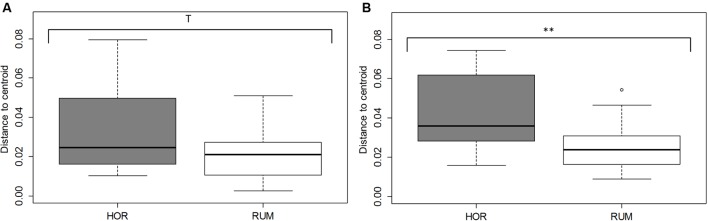
Dispersion of fermentation parameter data [molar concentrations of Ammonia, Acetate, Propionate, N-butyrate, branched-chained VFA and Lactate, log concentrations of LAB, AAB and yeast, pH and coefficients “a+b” (potential of fermentation) and “c” (speed of fermentation)], measured as distance form their corresponding centroid. Bray–Curtis method was used to generate the distances between samples. RUM and HOR correspond to foregut and hindgut models, respectively. Figures were obtained from multivariate data from direct values (A) or after subtracting their respective blanks (B). T means 0.1 > P > 0.05; ∗∗P < 0.01.